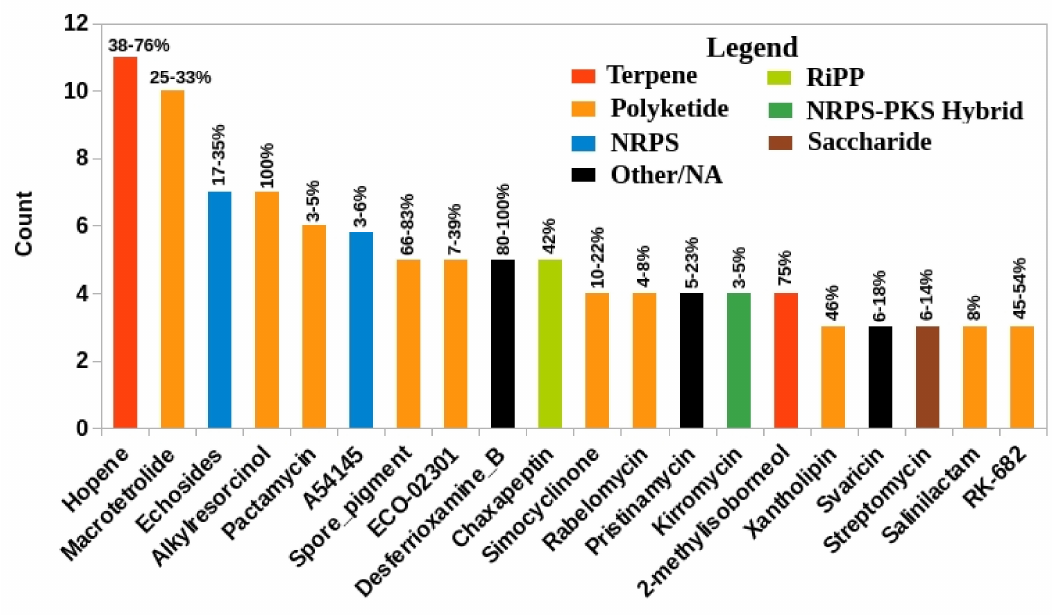
Figure 4. Most abundant known BGCs in Streptacidiphilus . Bar color indicates the classification of each cluster type in MIBiG database. Numbers above the bars indicate the range of percent similarity shown the clusters against known